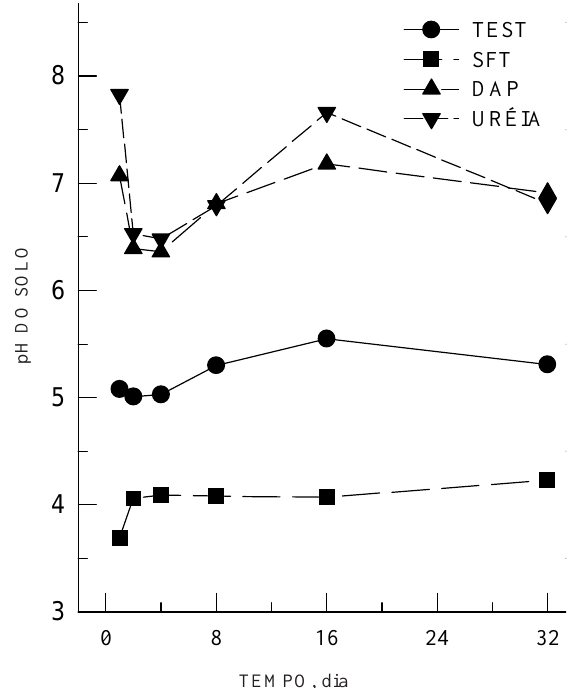
Figura 1. Valores de pH do solo em diferentes épocas após a mistura de uma alta dose (20% em peso) de superfosfato triplo (SFT), diamônio fosfato (DAP), ou uréia com um Latossolo Bruno. Média de três